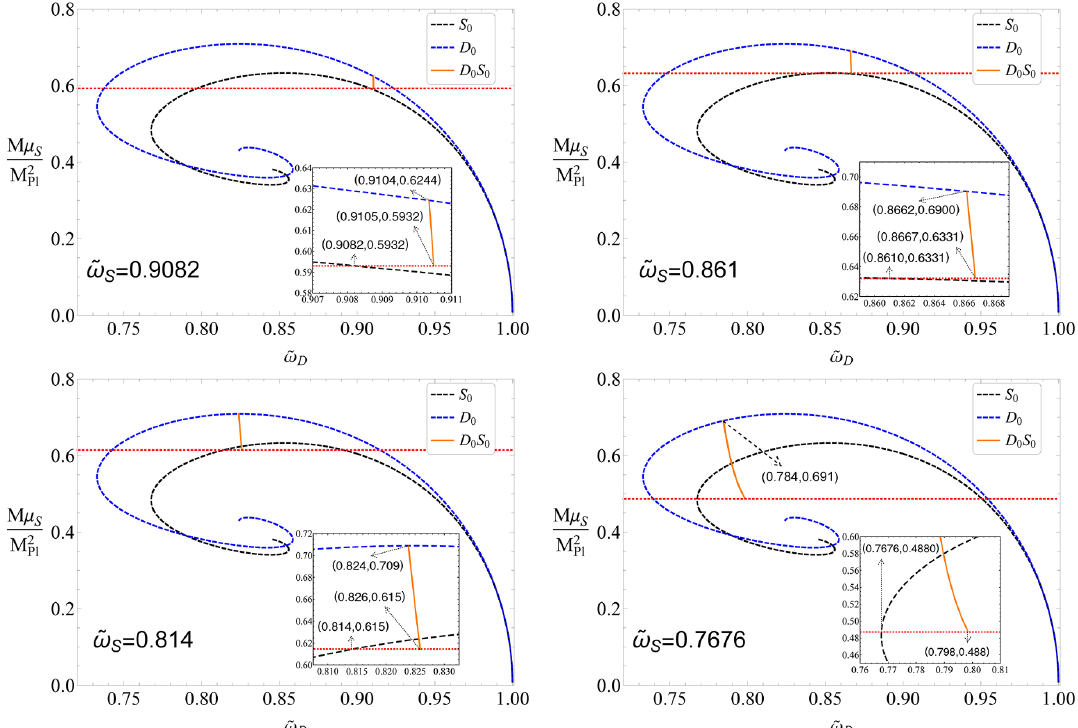
Figure 6. The ADM mass M of the DBSs as a function of the nonsynchronized frequency ˜ ω D for ˜ ω S = 0 . 9082 , 0 . 861 , 0 . 814 , 0 . 7676 . The black dashed line represents the S 0 state solutions, the blue dashed line represents the D 0 state solutions, the red horizontal dashed line represents the ADM mass of the BSs with S 0 state when ˜ ω S takes the value marked in the figure, and the orange line denote the coexisting state D 0 S 0 . All solutions have ˜ µ D = ˜ µ S = 1